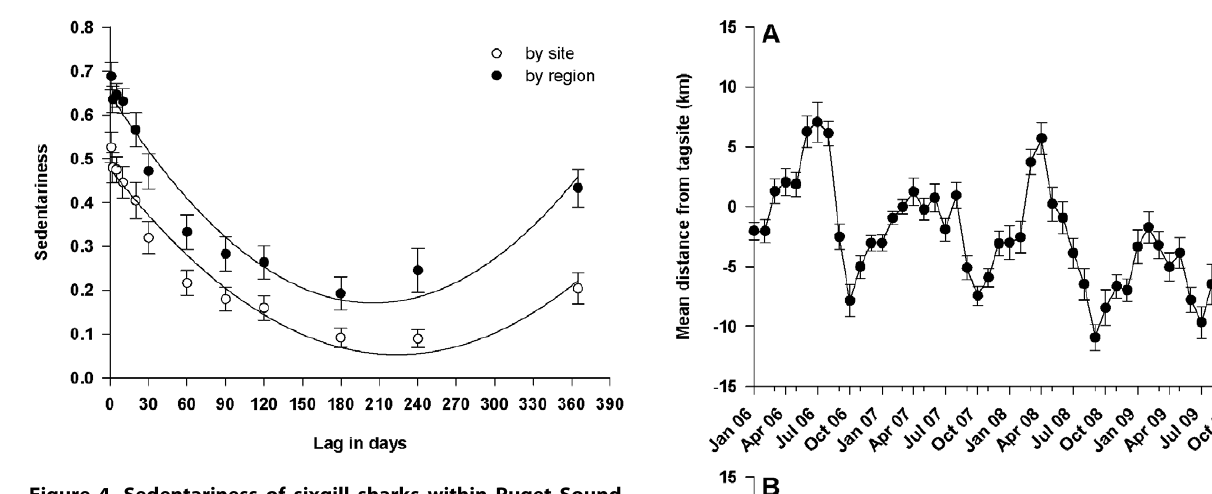
Figure 4. Sedentariness of sixgill sharks within Puget Sound, WA, USA. Sedentariness is the proportion of days a shark is detected at the same site (or region) at various lags of time from any point in the monitoring data. The parabolic relationship shows an annual pattern in which sixgills are sedentary within a site (or region) for weeks at a time, move slowly away to a second core area after six months, and then return to the original core area at the same time each year.